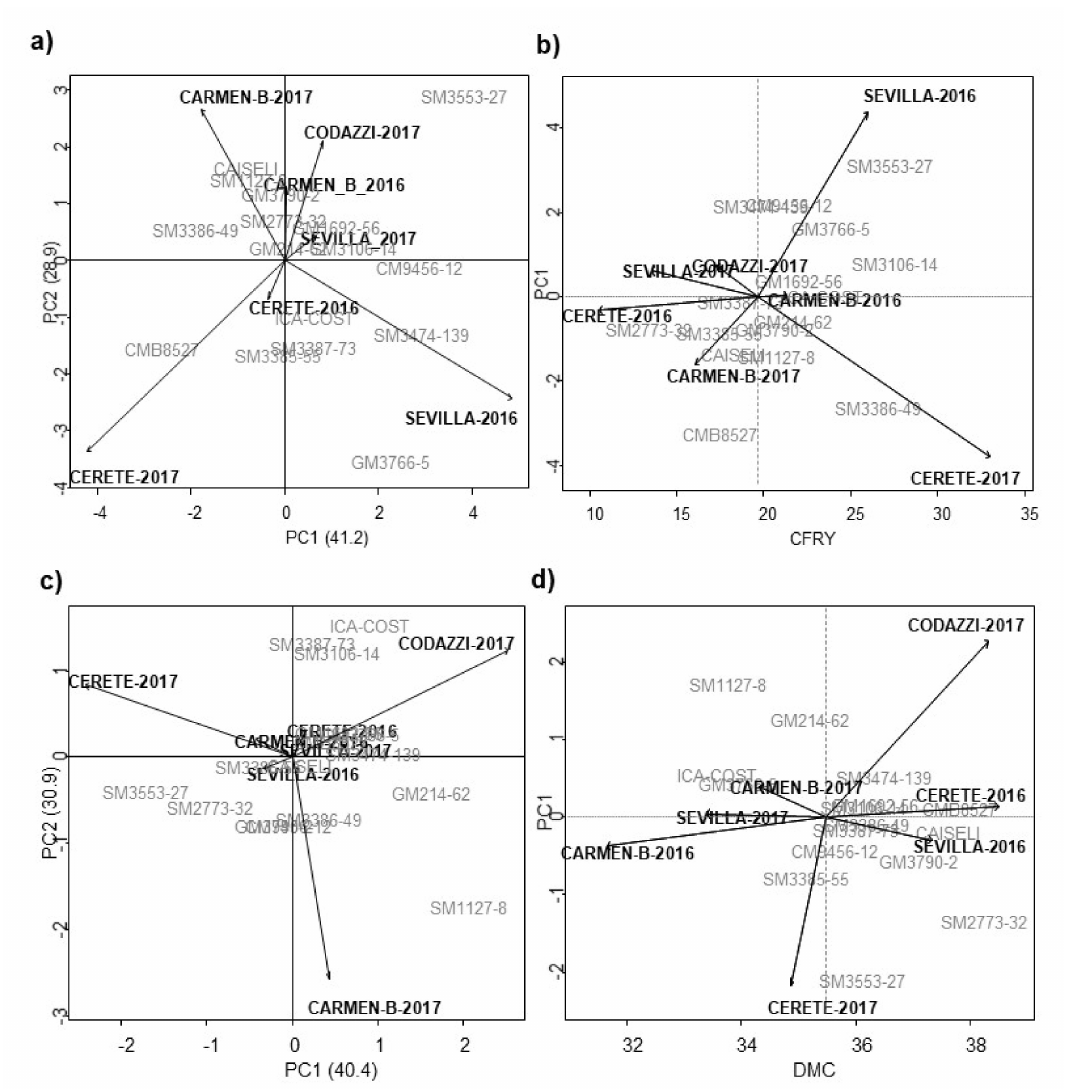
Figure 5. Biplot of AMMI analysis of the total yield and dry matter content. ( a ) Biplot obtained between PC1 and PC2 for total yield. ( b ) Biplot between PC1 and total commercial yield. ( c ) Biplot obtained between PC1 and PC2 for dry matter content. ( d ) Biplot between PC1 with the dry matter